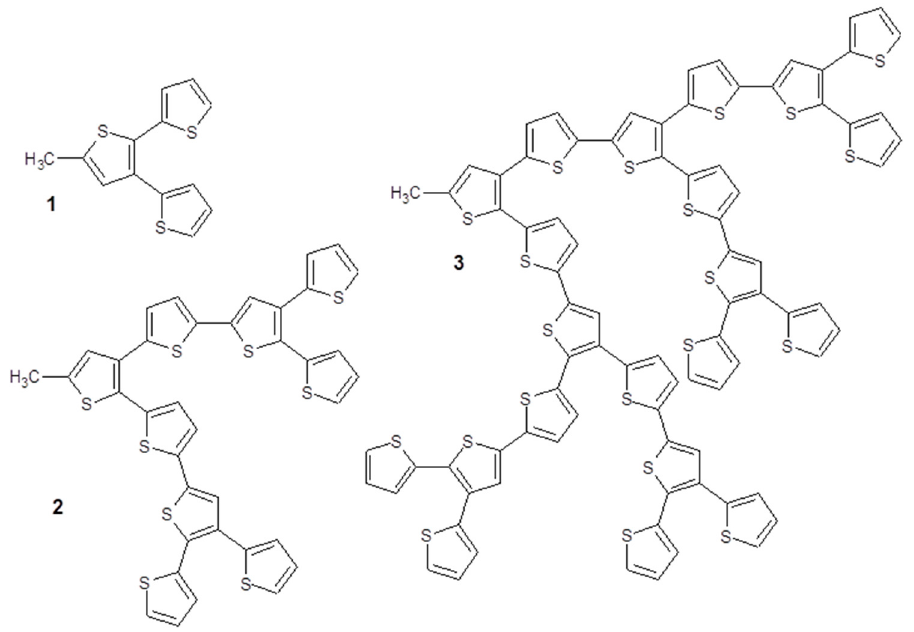
Figure 18. Molecular structures of the oligothiophene ligands used in [108].